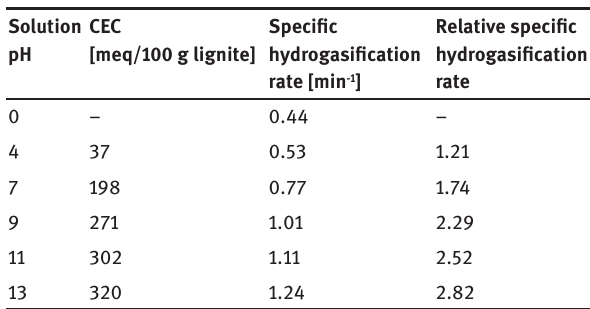
Table 2: Specific hydrogasification rates of low rank coal samples impregnated by K CO solutions of various pH. 2 3